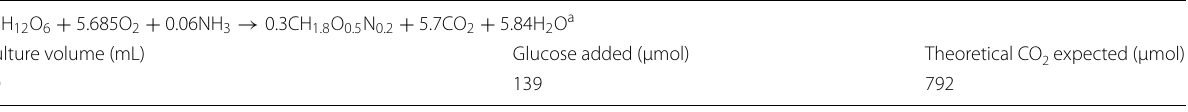
a Biomass empirical formula was taken from Shuler and Kargi (2008). Stoichiometric calculation for biomass utilization was based on the study by Edwards and Grbi ć ‑